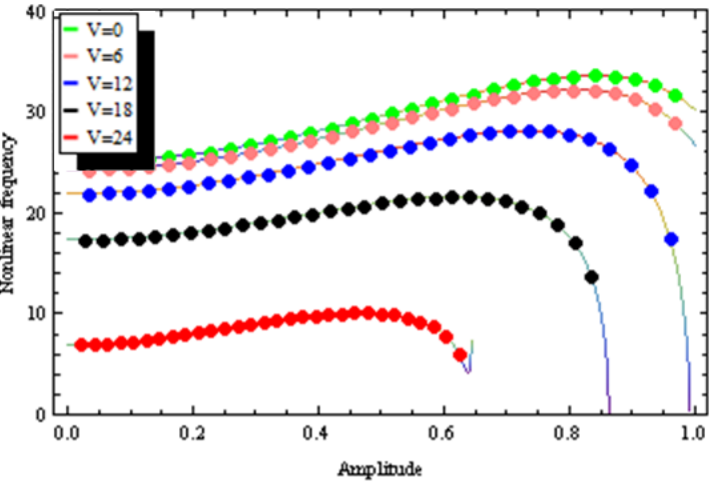
Figure 4. Effect of parameter V on nonlinear frequency of electrostatically actuated micro beam.